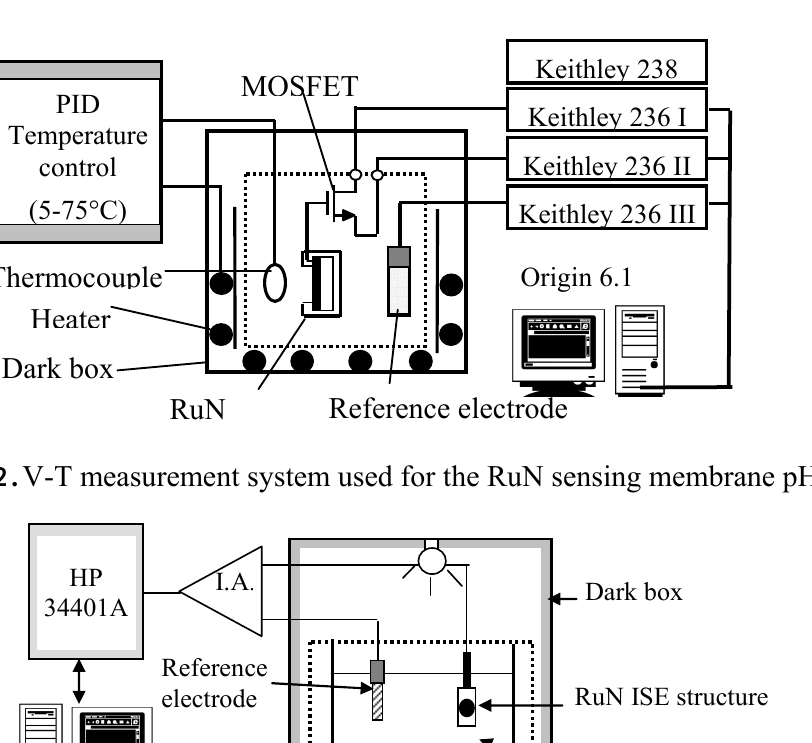
Figure 1. I-V measurement system used for the RuN pH-sensing membrane with separative extended gate field effect transistor.